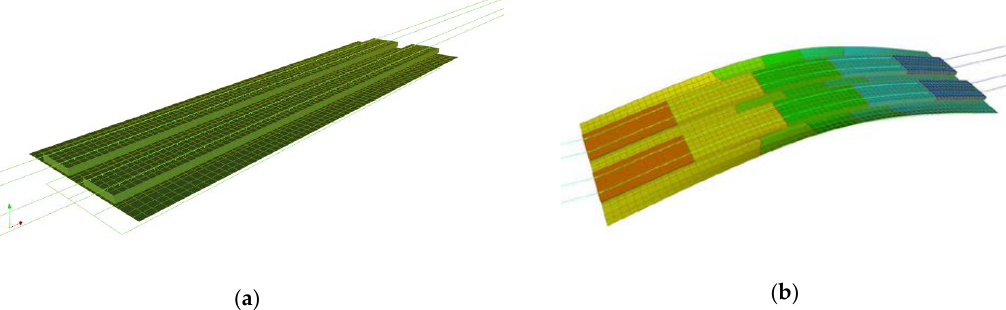
Figure 12. Identified natural frequencies of the first mode using: ( a ) Accelerometer data; ( b ) FBG sensor data. The dynamic analysis of the bridge structure was performed. To that goal, a three- analysis. Two-node beam elements were used for the girder and cross beams, and four-